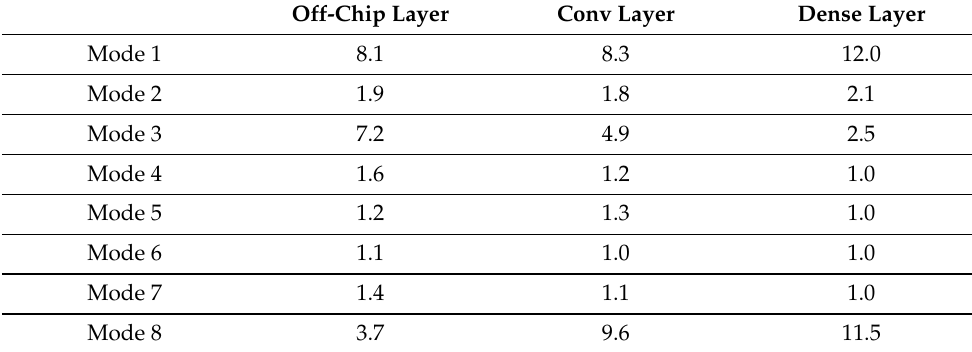
Table 2. Mean firing rates (Hz) for each